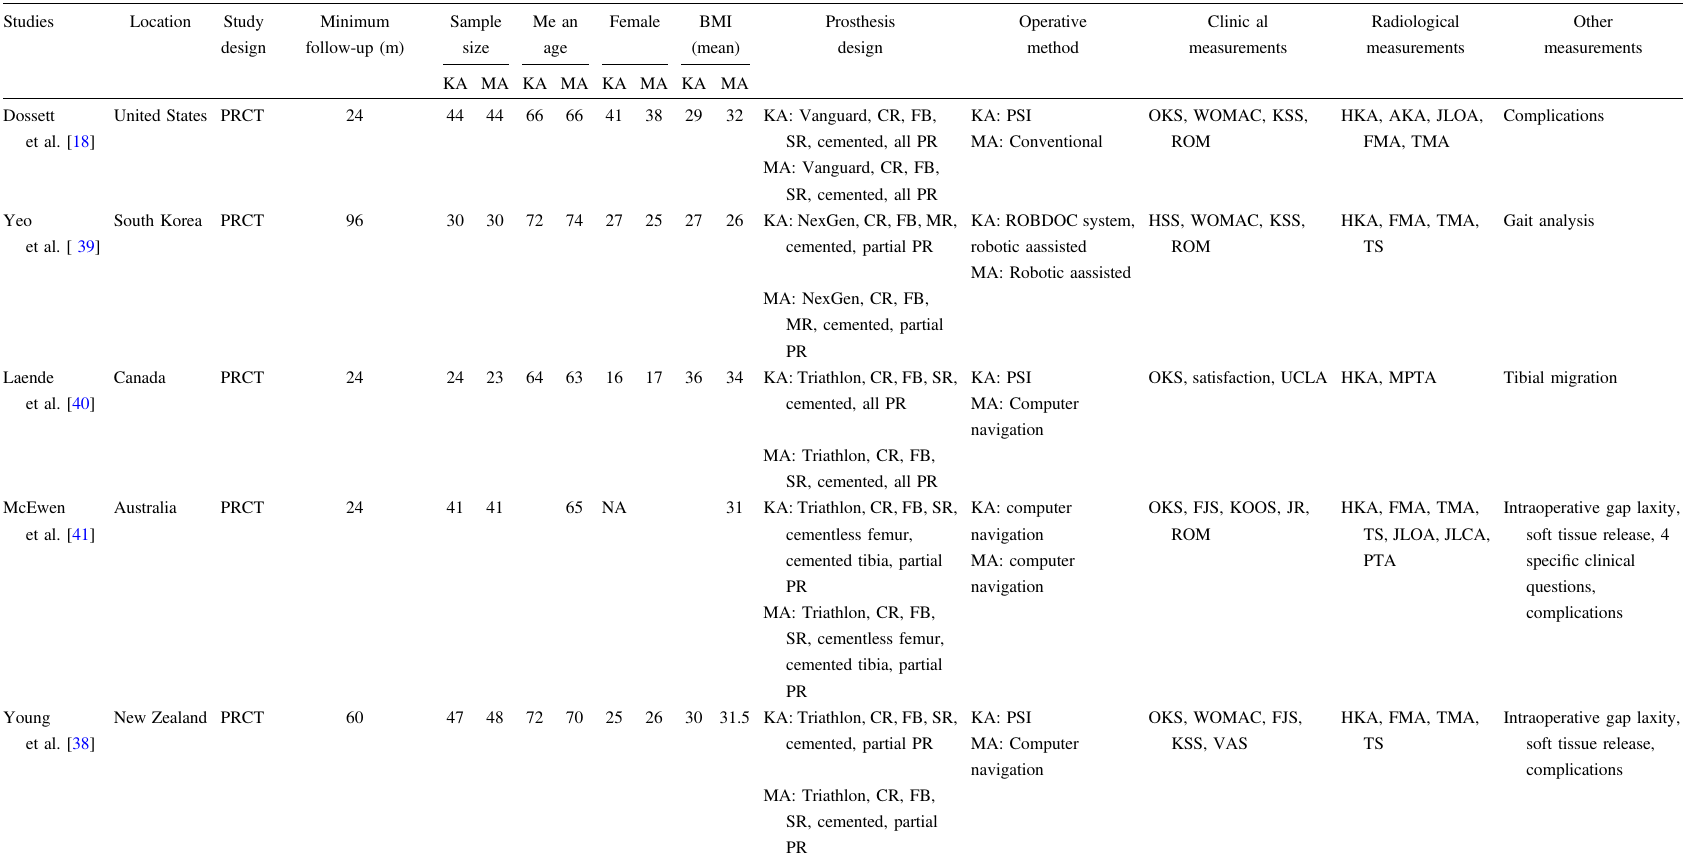
Table 1. Characteristic of the